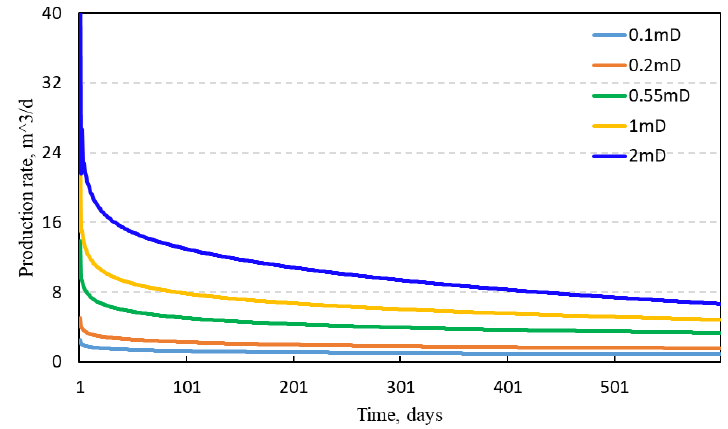
Figure 18. Production curves of permeability effect.